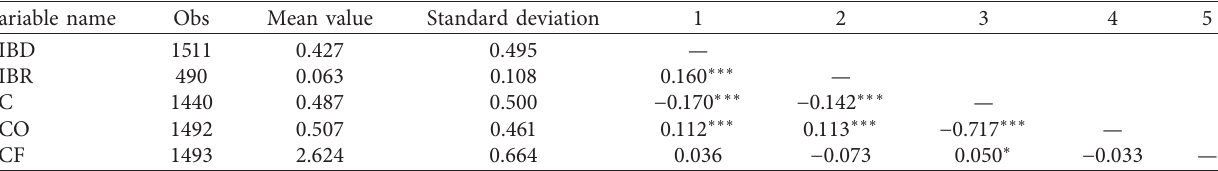
Table 2: Descriptive statistics and correlation analysis of main variables.